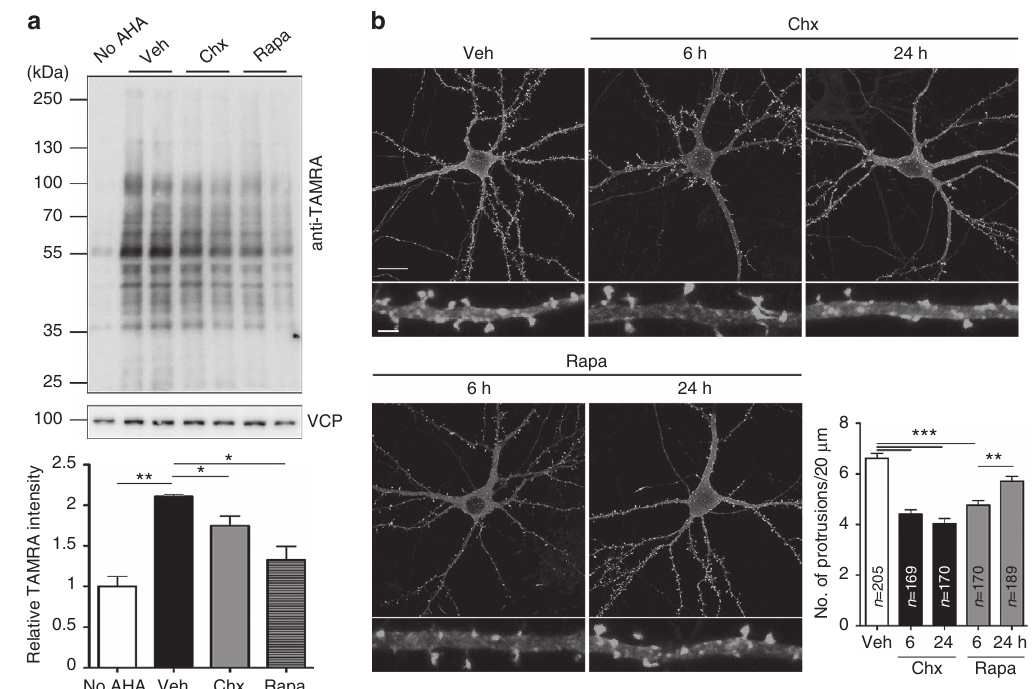
Figure 8 | Inhibition of translation using cycloheximide and rapamycin reduces the dendritic spine density. ( a ) Cycloheximide (Chx, 10 m M) and rapamycin (Rapa, 10nM) treatment for 6h inhibited protein synthesis of cultured neurons as revealed by the AHA signals with the TAMRA antibody. Images have been cropped for presentation. Full-size images are presented in Supplementary Fig. 9. ( b ) Cultured neurons transfected with GFP-actin to outline dendritic spines were treated with Chx and Rapa for 6 or 24h before immunostaining with the GFP antibody. Veh, vehicle. Scale bars: original, 20 m m; enlarged, 2 m m. The sample sizes ( n ) of the examined dendrites are indicated. The data from three independent experiments are presented as